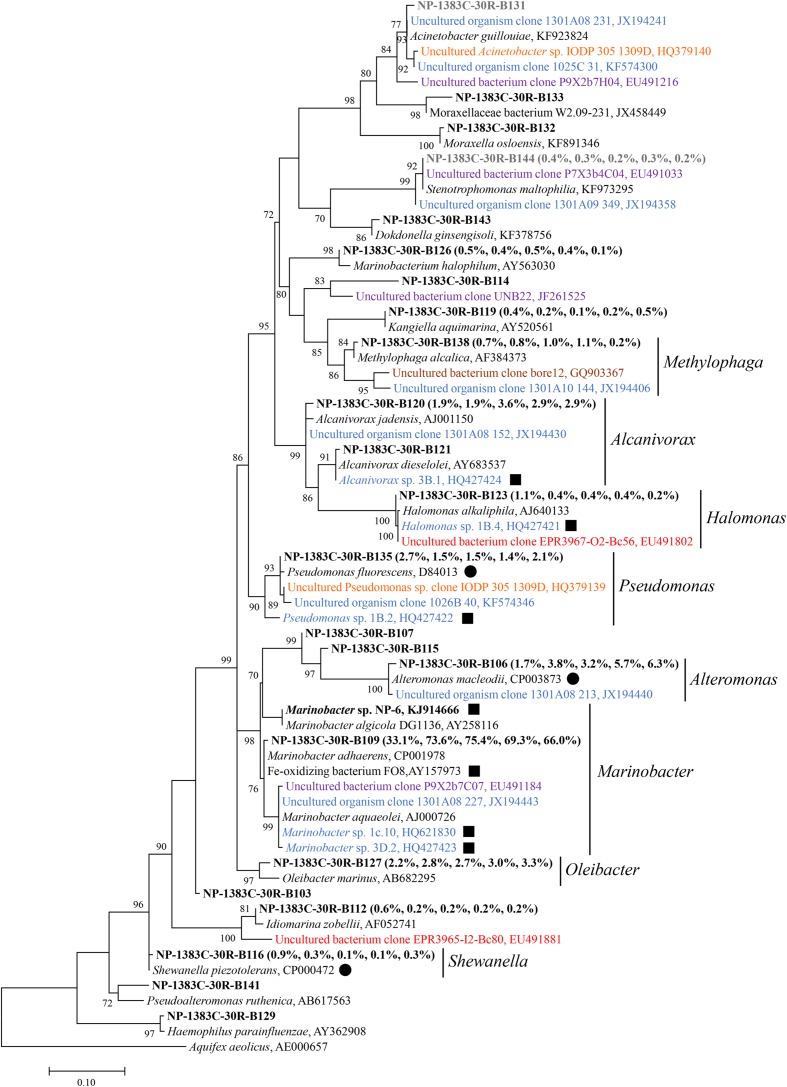
Phylogenetic tree of Gammaproteobacteria related 16S rRNA gene sequences from host rock sample 30R-1A in comparison to sequences from cultivated species and other environmental studies. The sequence data of 30R-1A host rock are retrieved from Zhang et al. (2016), and are highlighted in bold font. The numbers in parentheses indicate percent abundance of the reads clustered in genera followed by the order “Host rock” “NaHCO3 + NH4Cl” “NH4Cl” “NaHCO3 + NaNO3” “NaNO3,” respectively. A representative sequence from sample 30R-1A for each genus is shown due to the high sequence number. Sequences from isolates or other environmental studies identified by Genbank accession number. Filled squares indicate known iron-oxidizing bacteria, and filled circles indicate known iron-reducing bacteria. Sequences retrieved from Atlantis Massif are in orange, East Pacific Rise in red, Loihi Seamount in purple, Juan de Fuca Ridge flank in blue, crustal fluids of Costa Rica Rift flank in brown. Potential kit contaminating sequences are in gray. The number at each branch indicates local support value, with only values >70 shown. The 16S rRNA gene of Aquifex aeolicus (AE000657) is used as outgroup. The scale bar indicates 0.1 nucleotide substitutions per site.